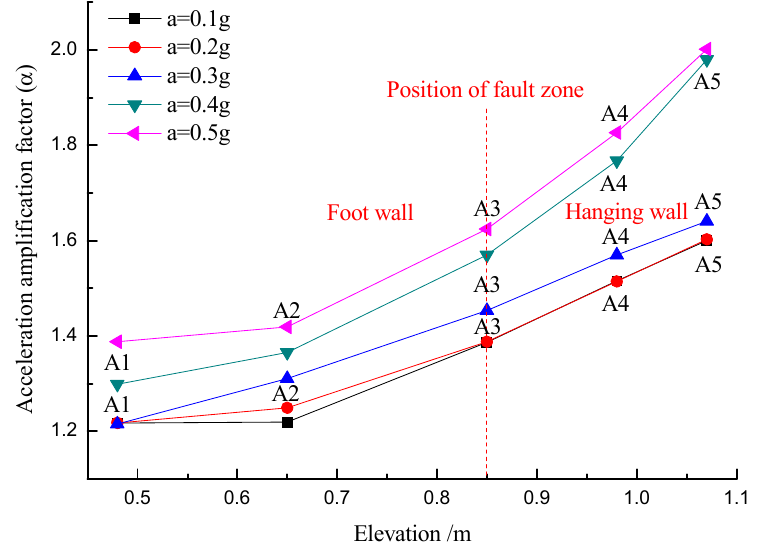
Figure 9. Variation in AAFs with elevation along slope surface in response to Minxian wave with different input PGA values.